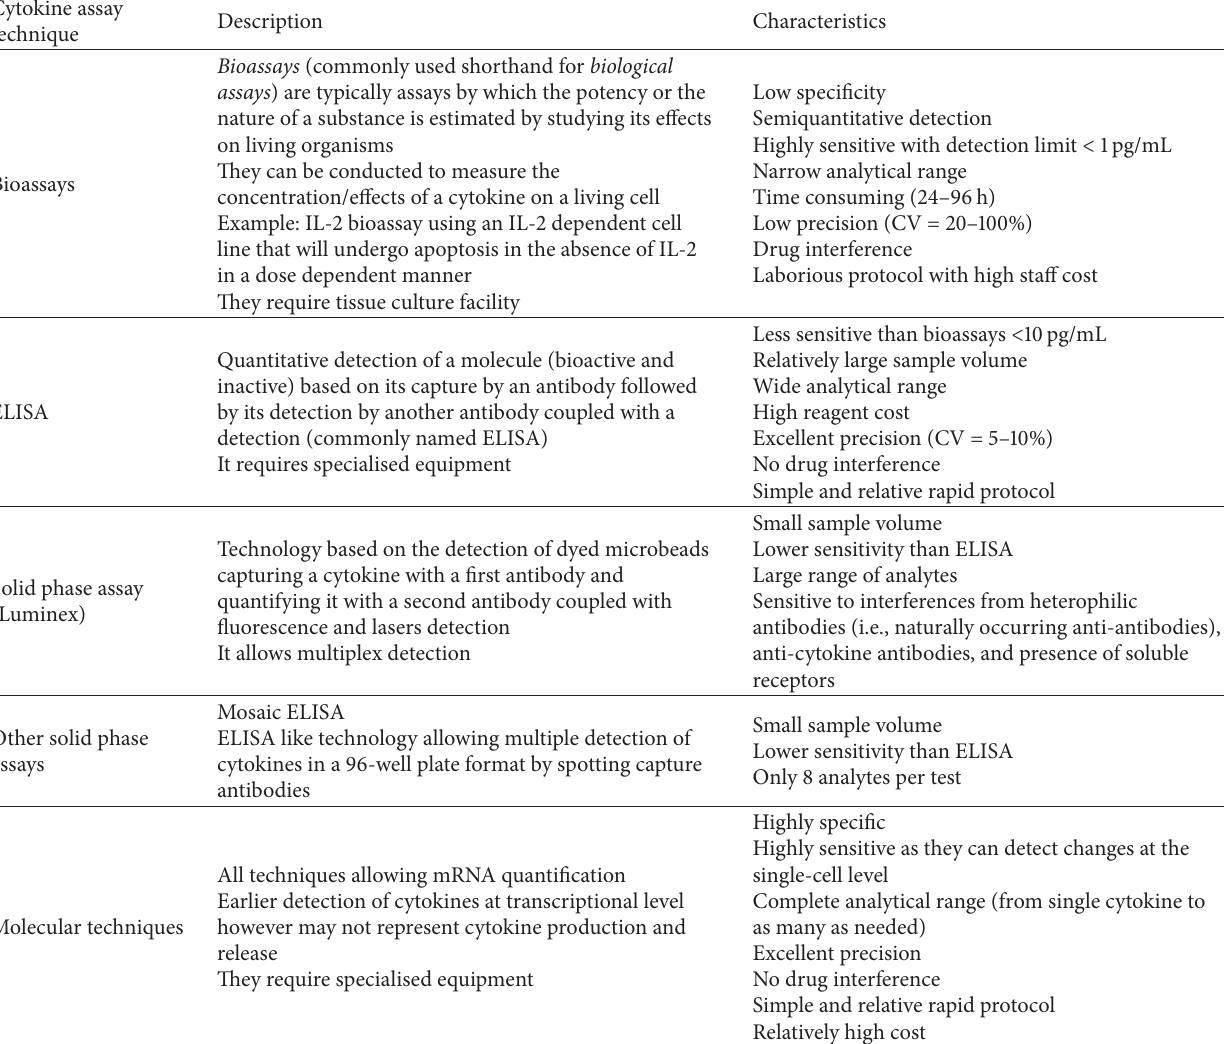
Table 2: Description and characteristics of assays measuring